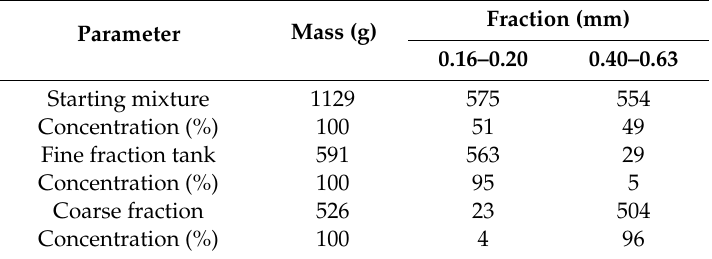
Figure 4. Estimation of the separation efficiency for the process of pneumatic classification. Table 1. Results of river sand separation.